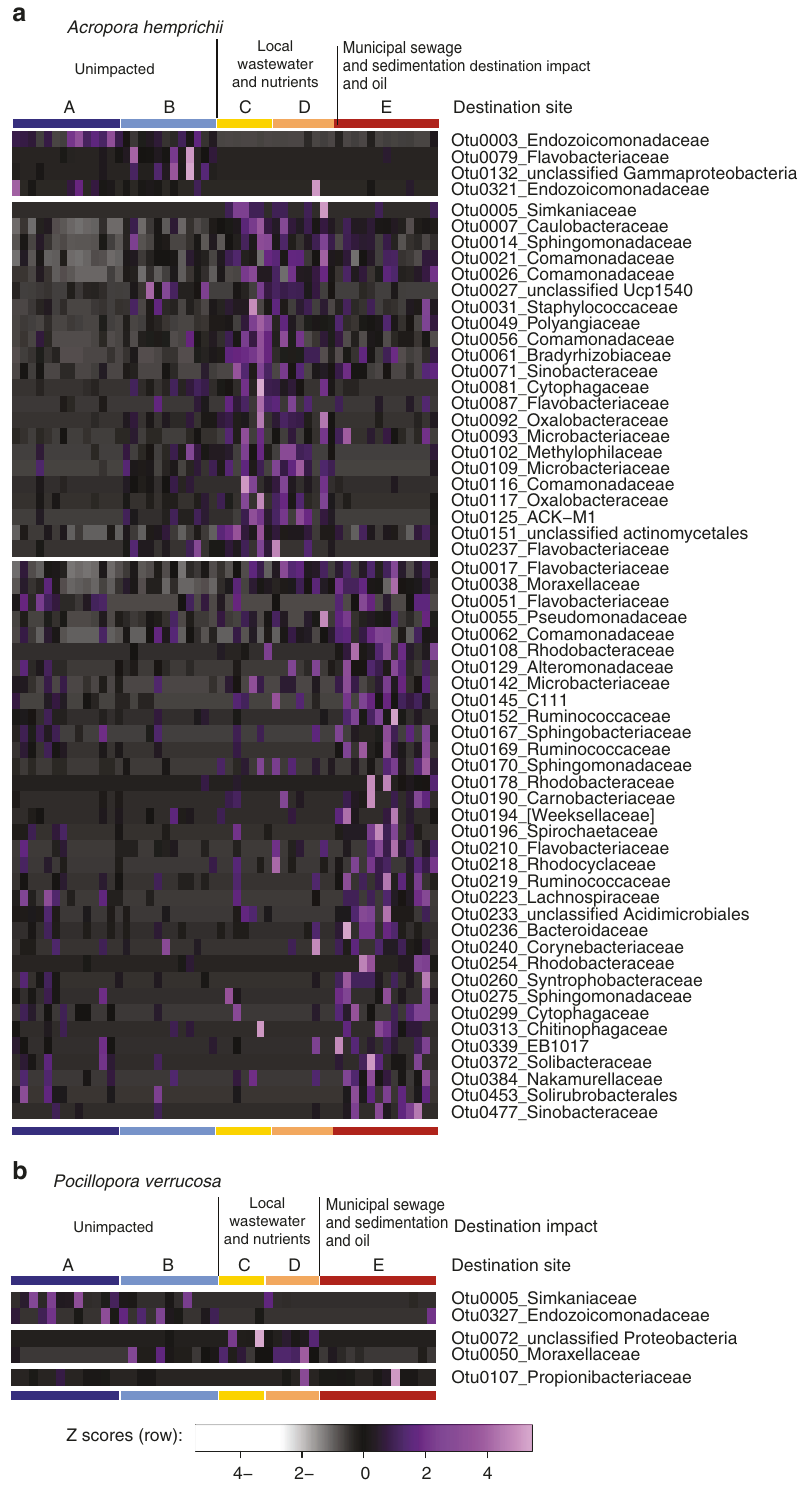
Fig. 3 Differentially abundant bacterial taxa (OTUs) over impacts. Bacterial taxa were associated with the corals a A . hemprichii and b P . verrucosa across sites of differing anthropogenic impact near Jeddah, Saudi Arabia. The fi rst cluster in each panel is signi fi cantly more abundant at unimpacted sites, the second cluster at sites exposed to local wasetwater and nutrients, and the third cluster at sites with municipal sewage and sedimentation and oil (LEfSe method, all LDA >2.0, p < 0.05). Sites and impacts marked with horizontal bars above the heatmaps. Source data are provided as a Source Data fi